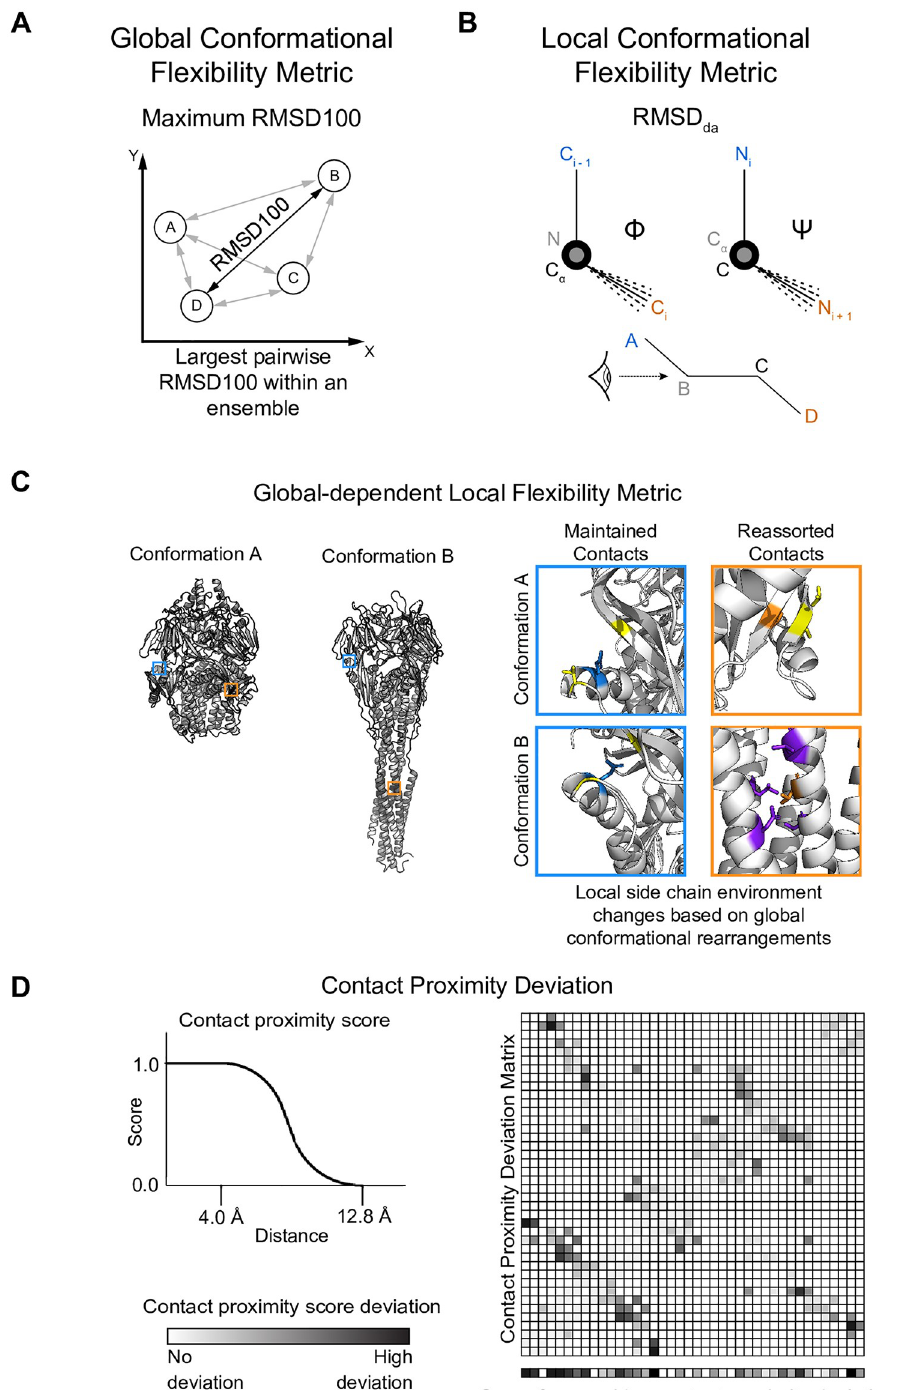
Fig 2. Metrics used to quantify conformational flexibility. (A) Illustration of maximum RMSD100, the metric used to quantify large-scale, or global, conformational flexibility. For simplicity, we only represent RMSD on a two- dimensional plane, where the x and y axes represent the difference in distance of cartesian space if two conformations were superimposed onto the same coordinate system. Each protein conformation of identical sequence is represented as a circle, and is separated by some distance vector evaluated as the RMSD100 of two conformations. The maximum RMSD100 describes the greatest pairwise RMSD100 within an ensemble. (B) Illustration of dihedral angle ϕ and φ variation used to calculate dihedral angle RMSD (RMSD da ). Orientation of atoms is color-coded and corresponds